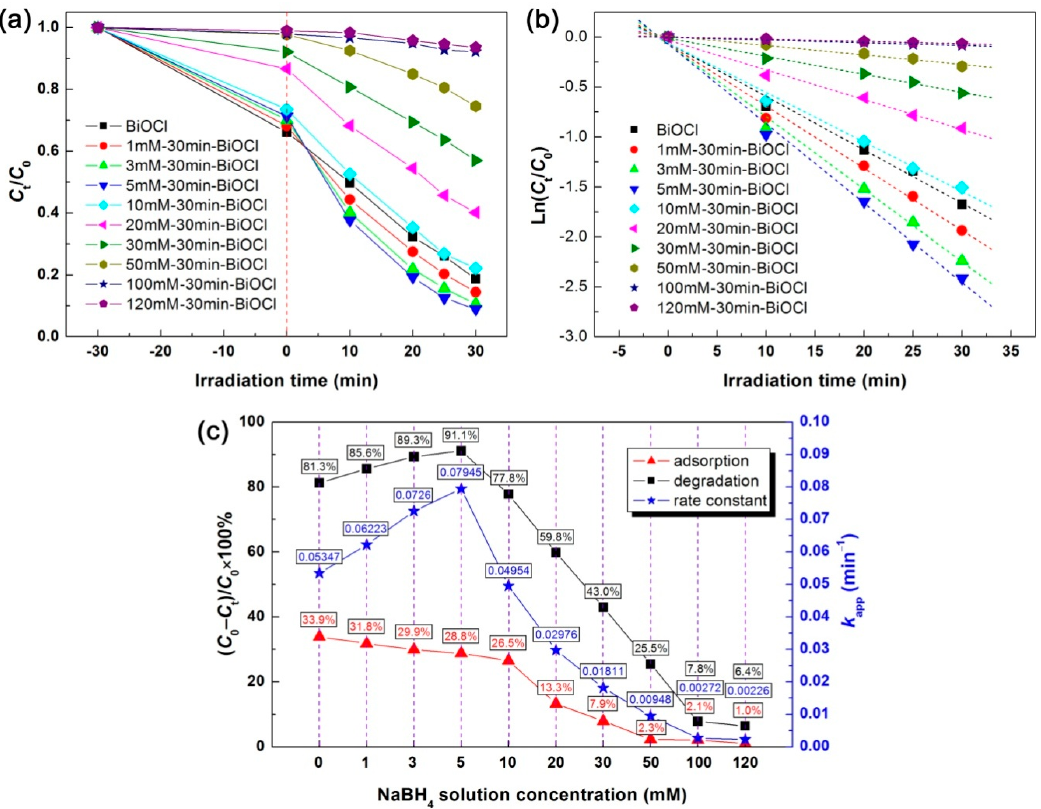
Figure 8. ( a ) Time-dependent photodegradation curves of RhB over the NaBH 4 -treated BiOCl samples with different concentrations. ( b ) The corresponding kinetic plots of the dye degradation. ( c ) The adsorption/degradation percentages of RhB and the apparent first-order reaction rate constants of the dye degradation.